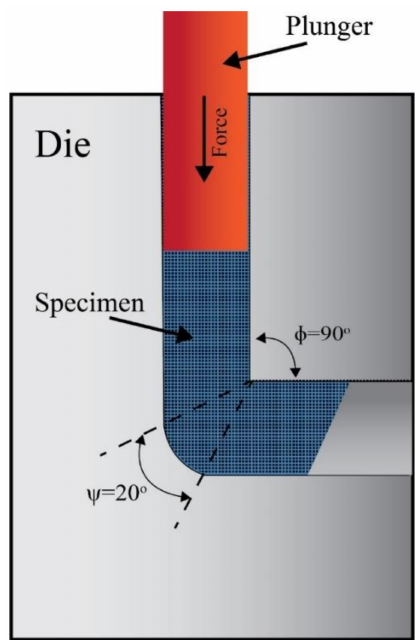
Figure 1. The schematic of the ECAP